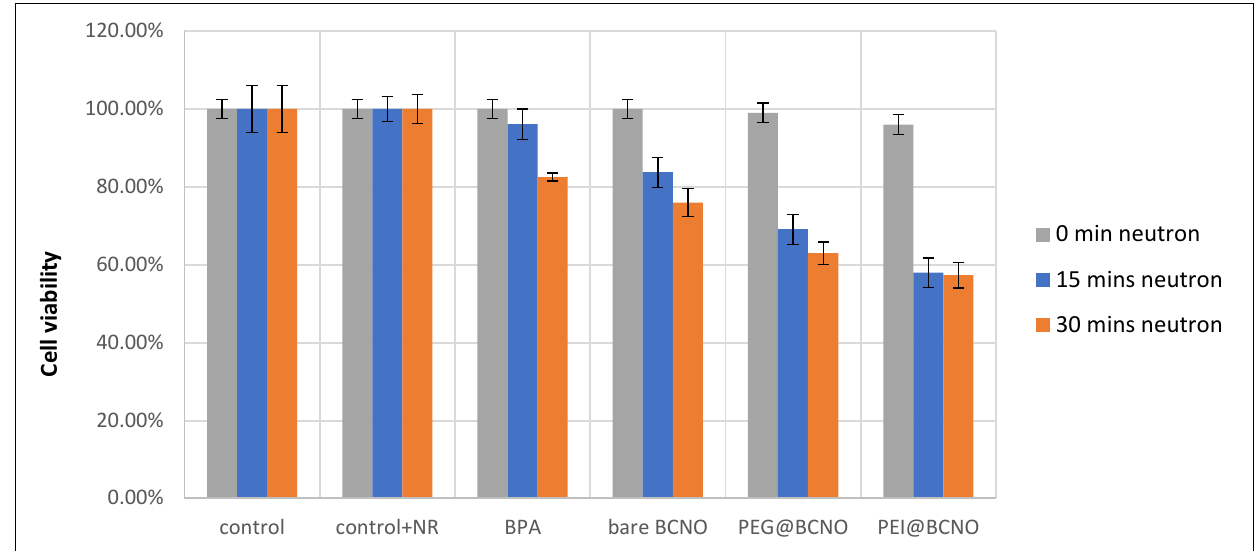
Figure 9. Normalized cell viabilities of ALTS1C1 cells as a function of neutron irradiation dose and BCNO nanoparticles. The ALTS1C1 cells were internalized with bare BCNO, PEG@BCNO and PEI@BCNO nanoparticles. The cell viability was measured at 6 h after neutron irradiation. The error bar represents the standard deviation of five independent measurements.